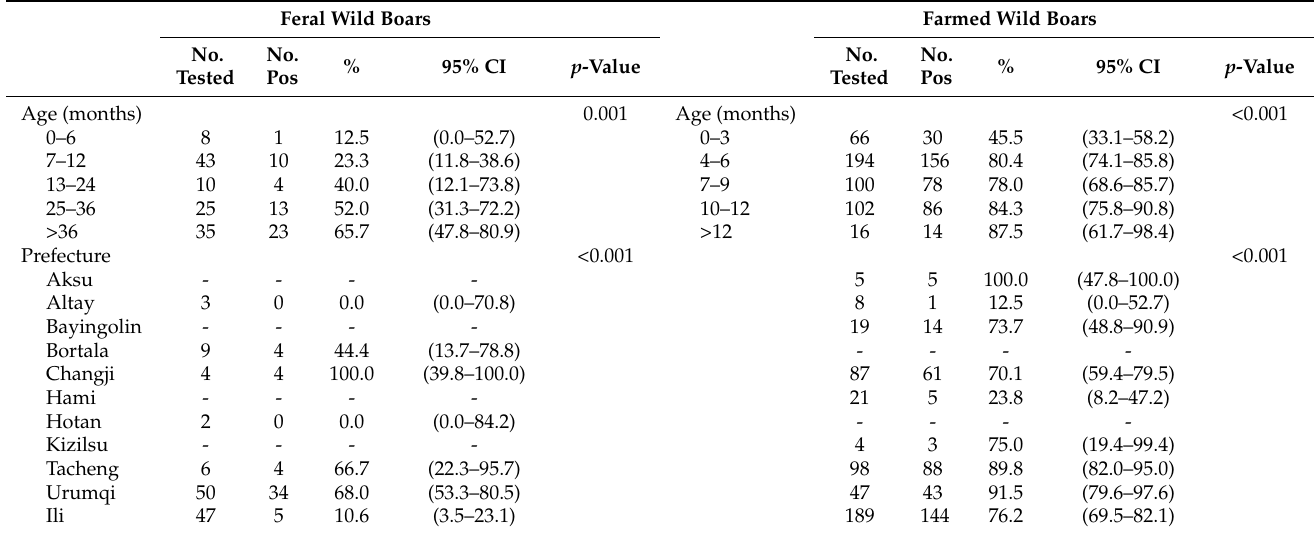
Table 3. HEV seroprevalence in feral and farmed wild boar populations.